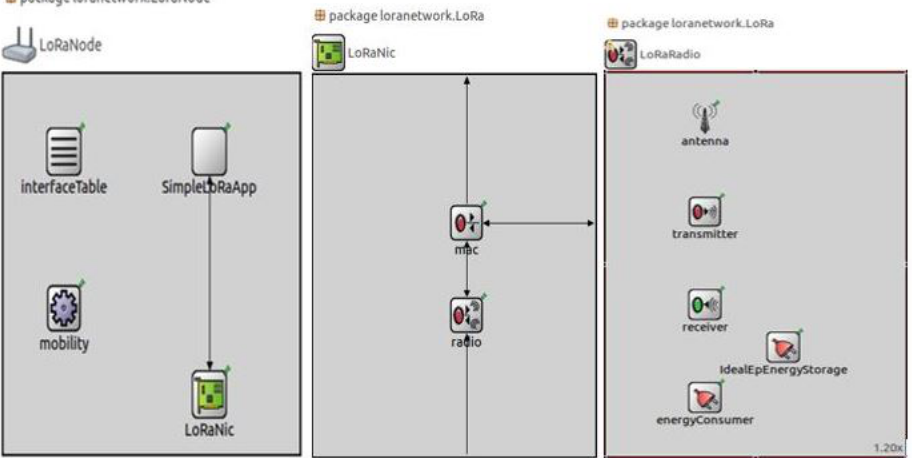
Figure 6. Sub-modules of LoRa Node.